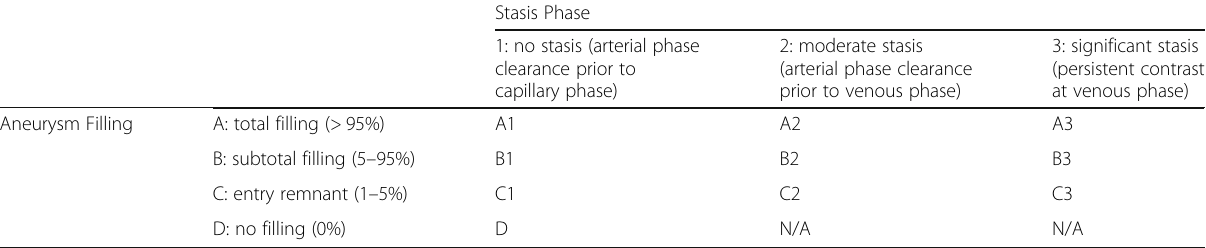
Table 1 O ’ Kelly-Marotta grading scale used to assess the degree of angiographic filling and contrast stasis when using flow diverter stents to treat aneurysms